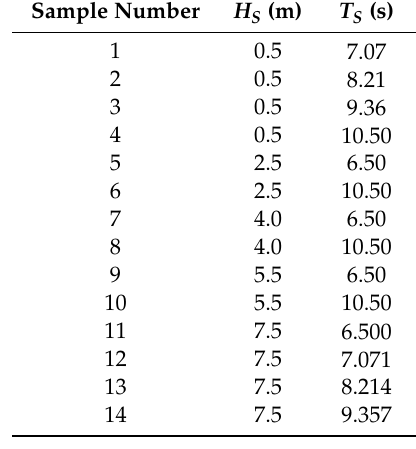
Table 5. Parameter settings for the test samples.